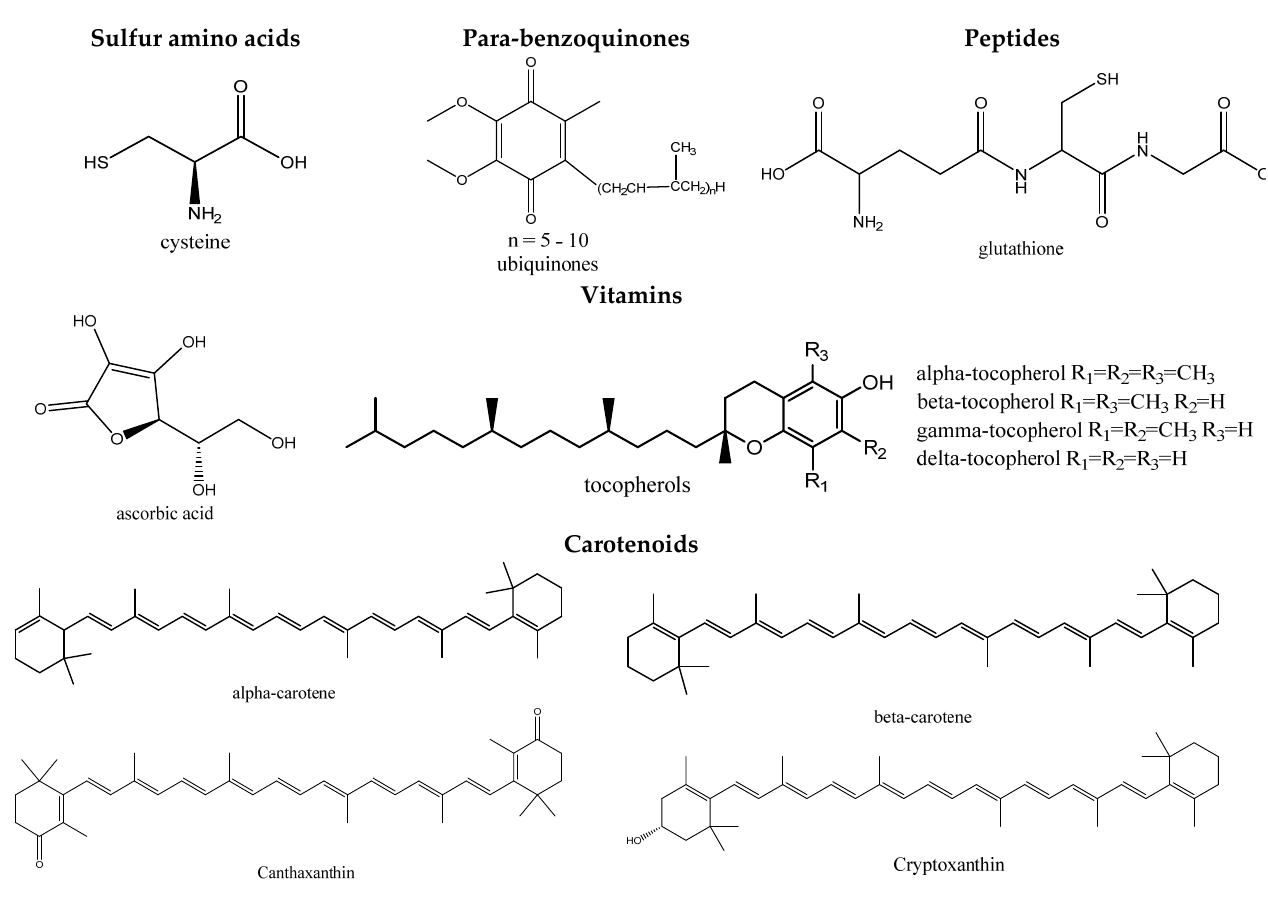
Figure 1. Structural formulas of some antioxidants.